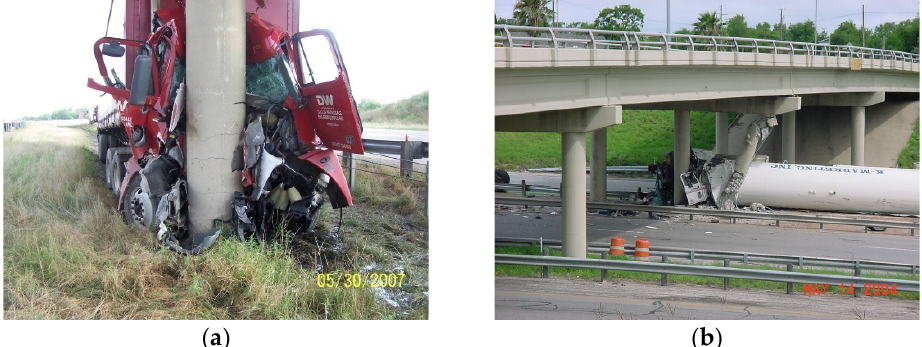
Figure 1. Classification of the latera impact process in design [16]. ( a ) Hard impact accident; ( b ) Soft impact accident.